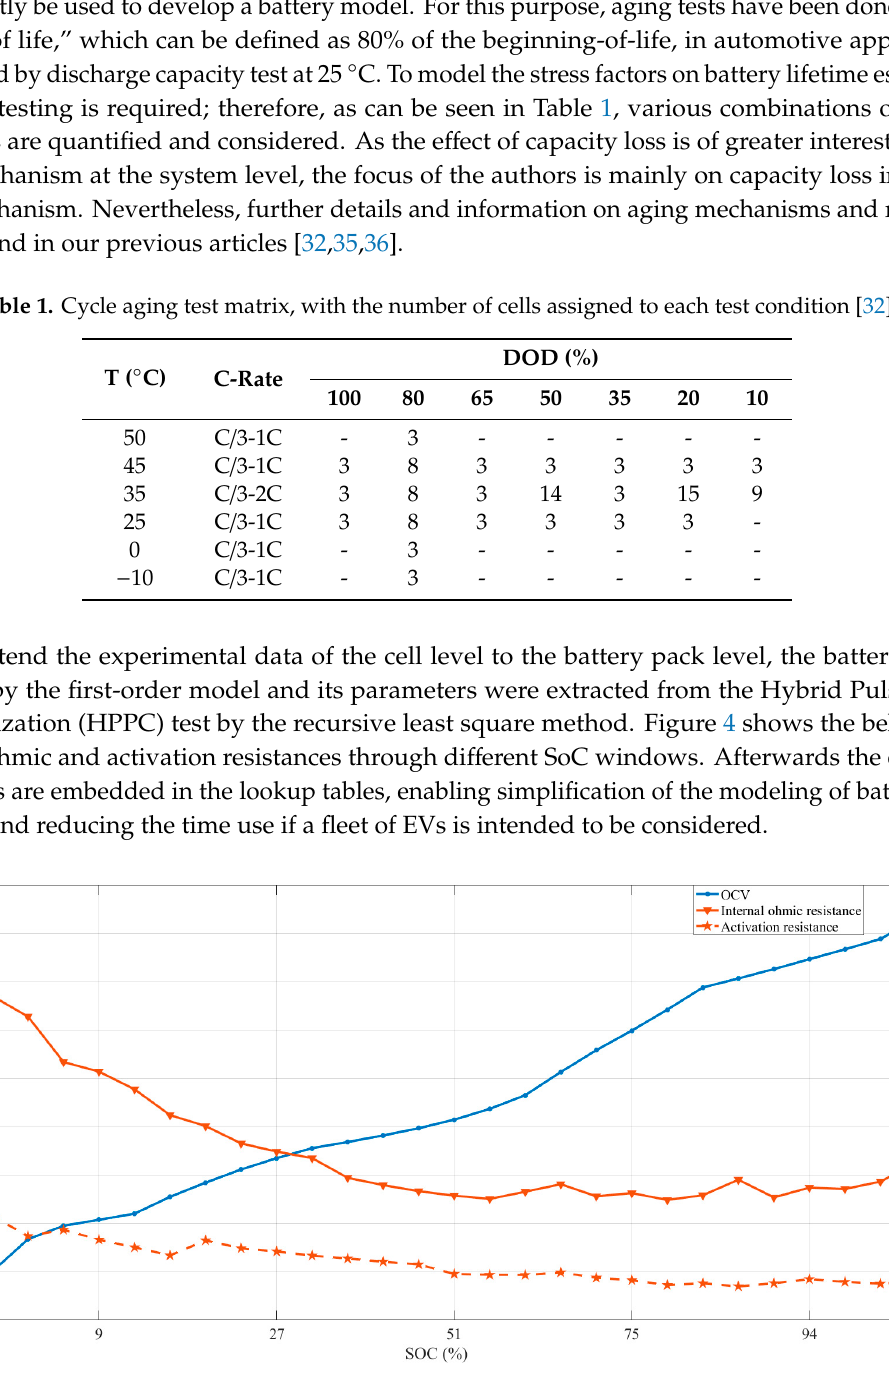
Figure 4. Behavior of internal resistance at different SoC.